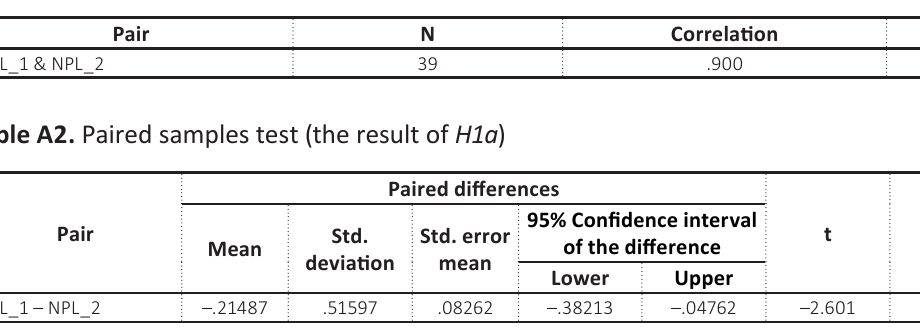
Table A1. Paired samples correlations (the result of H1a )